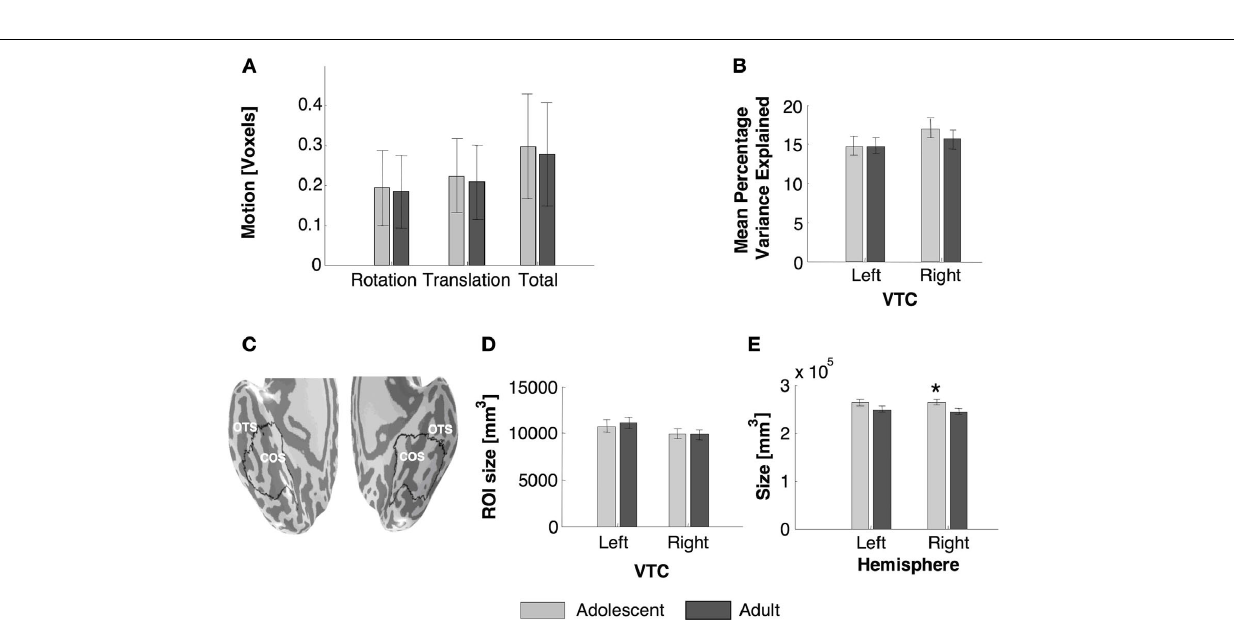
adolescent, OTS: occipito-temporal sulcus; CoS: collateral sulcus. (D) Average volume of the VTC in each age group. (E) Average volume of the total gray matter in each hemisphere for each age group. All bars represent the average across each age group (11 adults and 14 adolescents), error bars show standard error of the mean (SEM) for each age group. Asterisk indicates signifi cantly higher volume in adolescents than adults ( P < 0.05, t